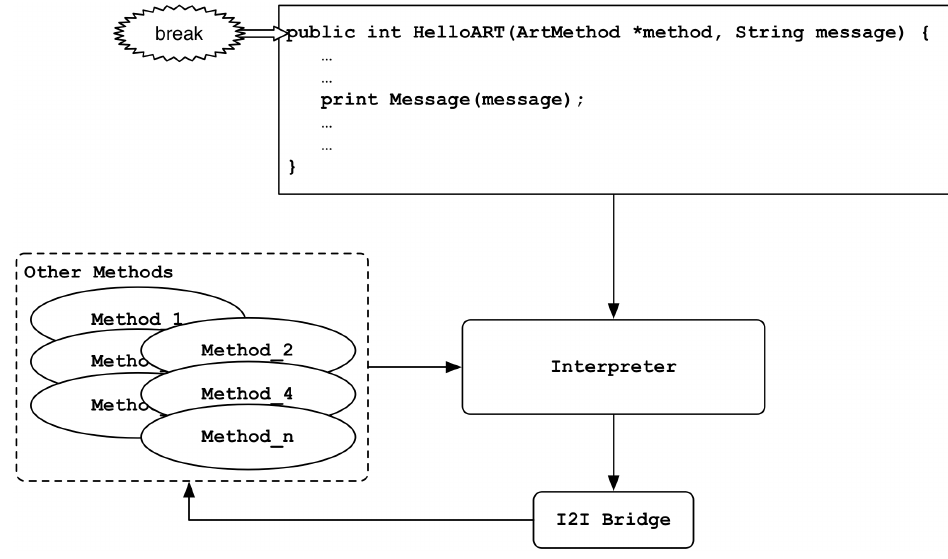
Figure 4. Set the event at method’s